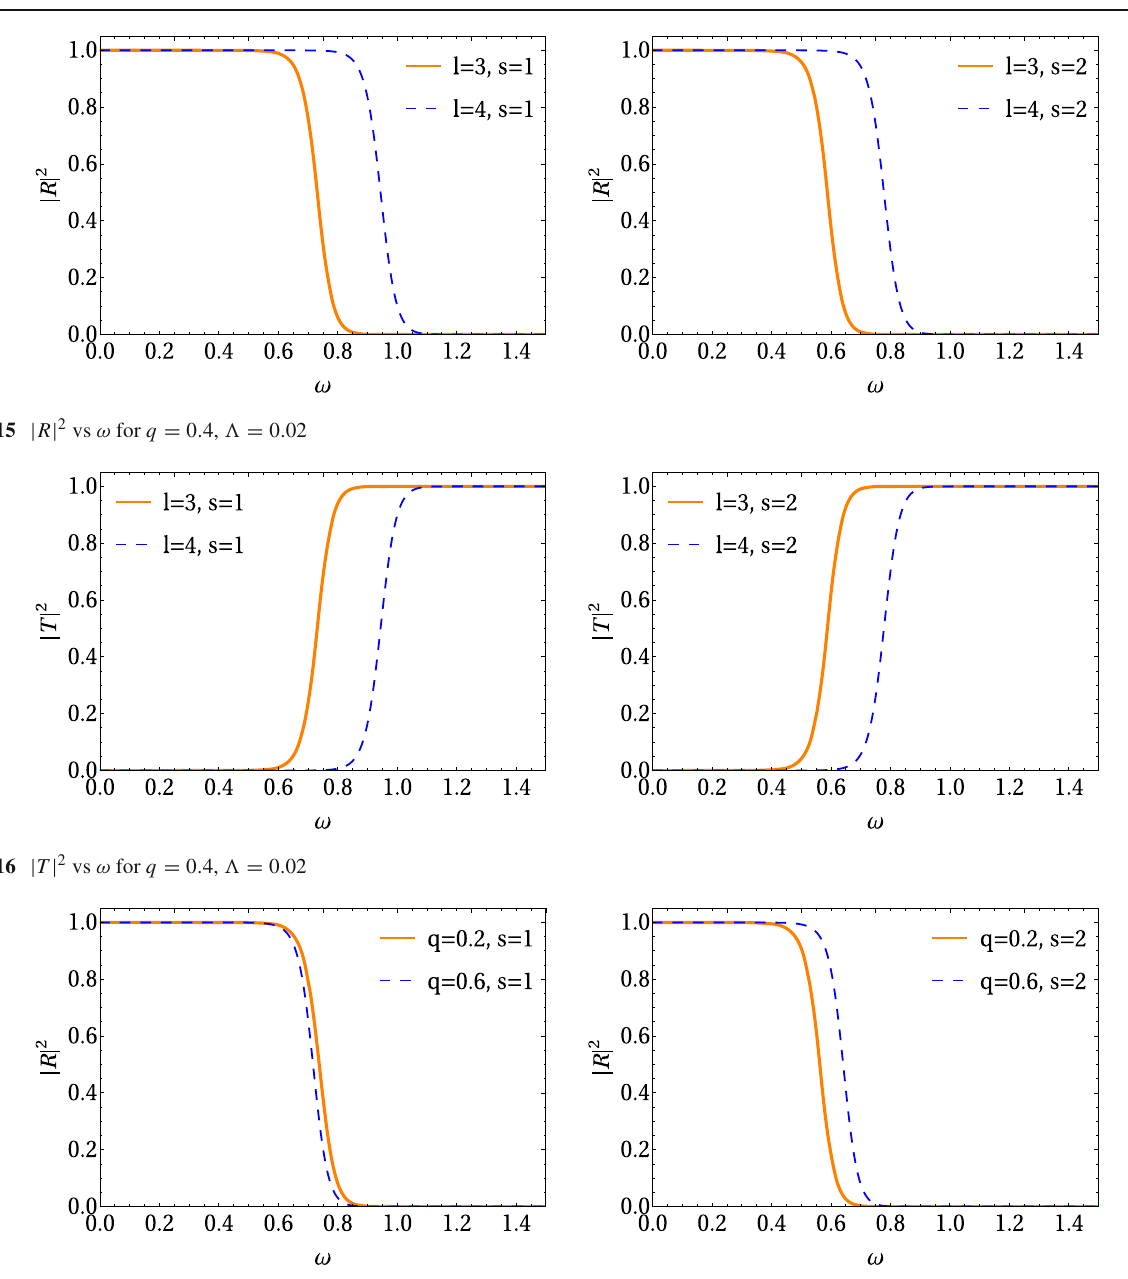
Fig. 17 | R | 2 vs ω with (cid:12) = 3 and (cid:2) = 0 . 02 for different magnetic charge ( q ) values